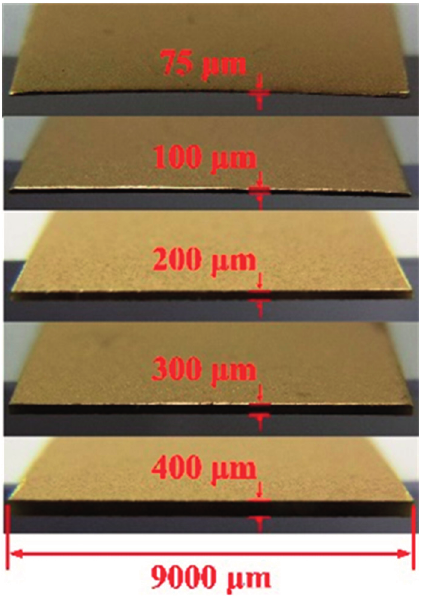
Figure 2. Fabrication flow of the PZT pyroelectric cell.